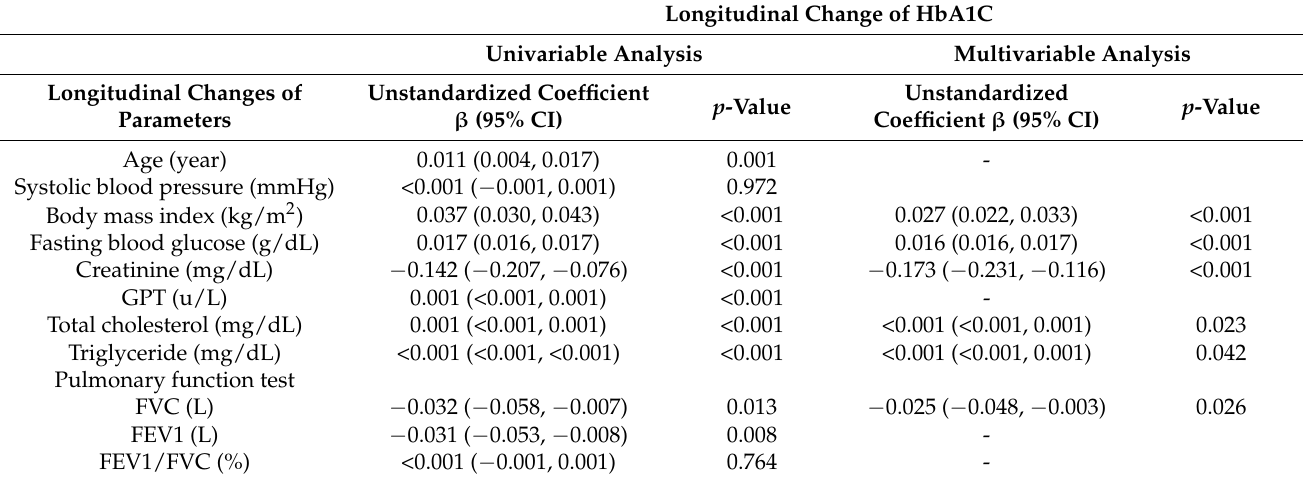
Table 3. Univariable and multivariable linear regression analyses for longitudinal changes of HbA1c.